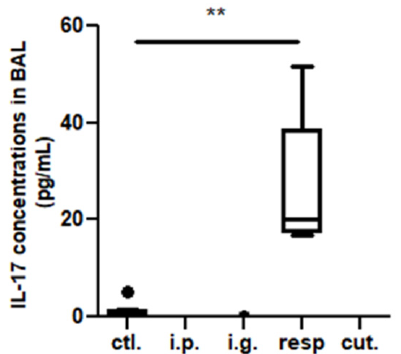
Figure 9. IL-17 concentrations in BAL from mice exposed through the different routes. ** p < 0.01: Using non-parametric Kruskal–Wallis test and Dunn’s post-test when comparing all groups to control one (non-exposed mice). The bold black dot represents an outlier.